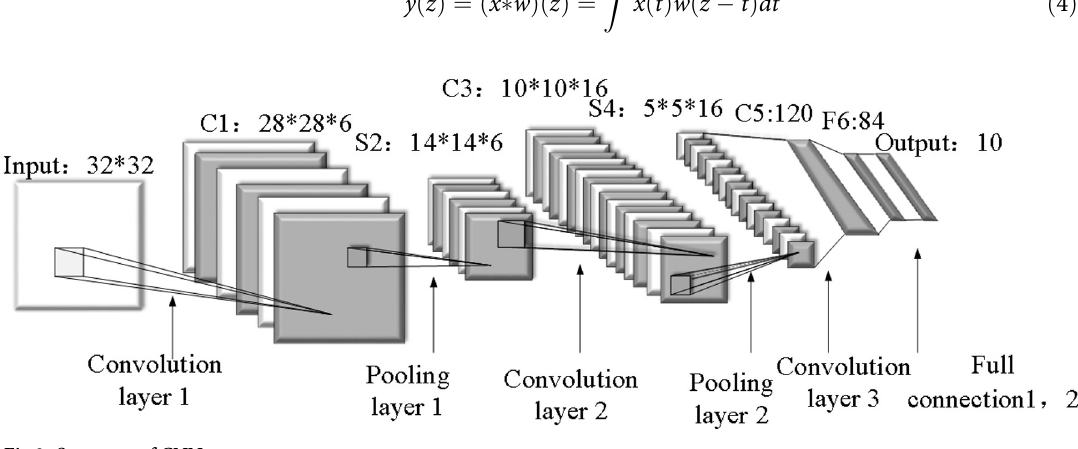
Fig 3. Structure of